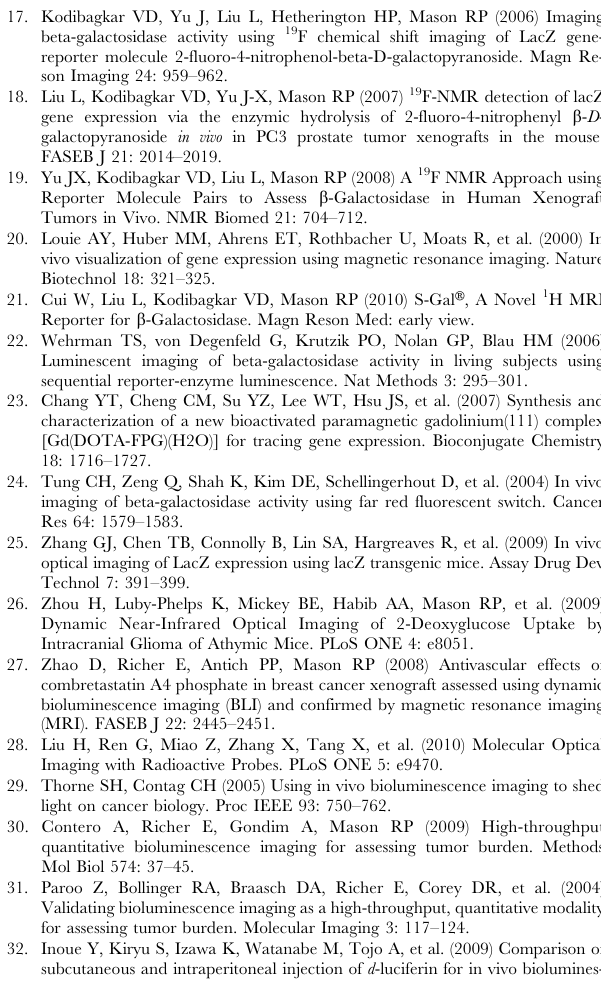
Figure S1 Emission spectrum for Galacto-Light PlusTM reaction mixture with b -gal. A mixture of substrate (0.5 m l Galacto-Light Plus), accelerant buffer (5 m l) and reaction buffer (4.5 m l) was observed after addition of b -gal enzyme (2 U b -gal in 10 m l PBS) with various emission filters from 500 nm to 840 nm. Inset shows similar spectrum obtained when minced MCF7-lacZ tumor tissue was used in place of enzyme. Found at: doi:10.1371/journal.pone.0012024.s001 (0.54 MB TIF) Figure S2 Verification of b -gal activity. a) Upper row sections from MCF7-lacZ tumor; Lower row from and MCF7-WT; (left) detection of b -gal based on X-gal staining and nuclear fast and (right) H&E staining. b) b -gal activity in tissues of mouse with MCF7-lacZ and -WT tumors determined using colorimetric assay. c) Protein expression based on Western blot confirming high activity of b -gal in lacZ tumor with about 10% background in MCF7-WT. Found at: doi:10.1371/journal.pone.0012024.s002 (1.22 MB TIF) Figure S3 Imaging b -gal activity in transgenic 129S-Gt (ROSA)26Sor/J mouse following SC injection of substrate. Following SC injection of Galacto-Light Plus reaction mixture (10 m l) highly localized light emission was observed from the region of injection. The time dependent signal intensity curve